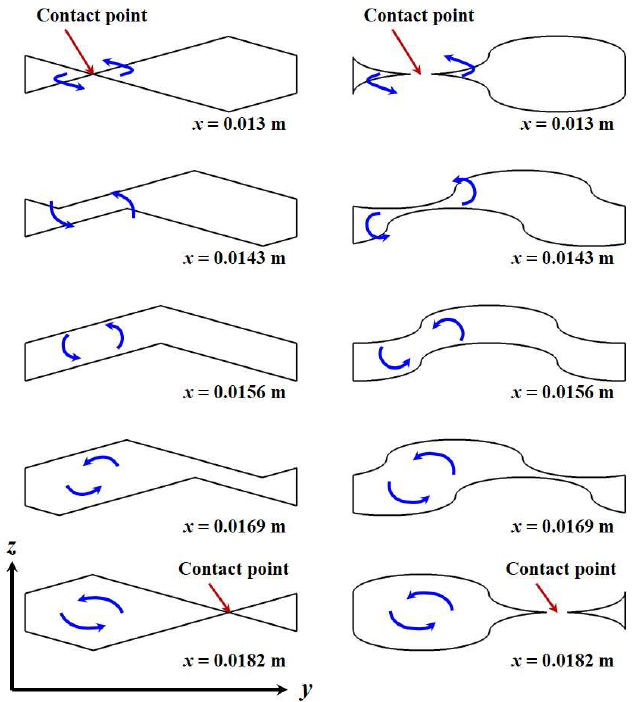
Figure 9. Flow motion according to the flow channel variation with triangular and elliptical corrugation profile at x = 0.013, 0.0143, 0.0156, 0.0169, and 0.0182 m.